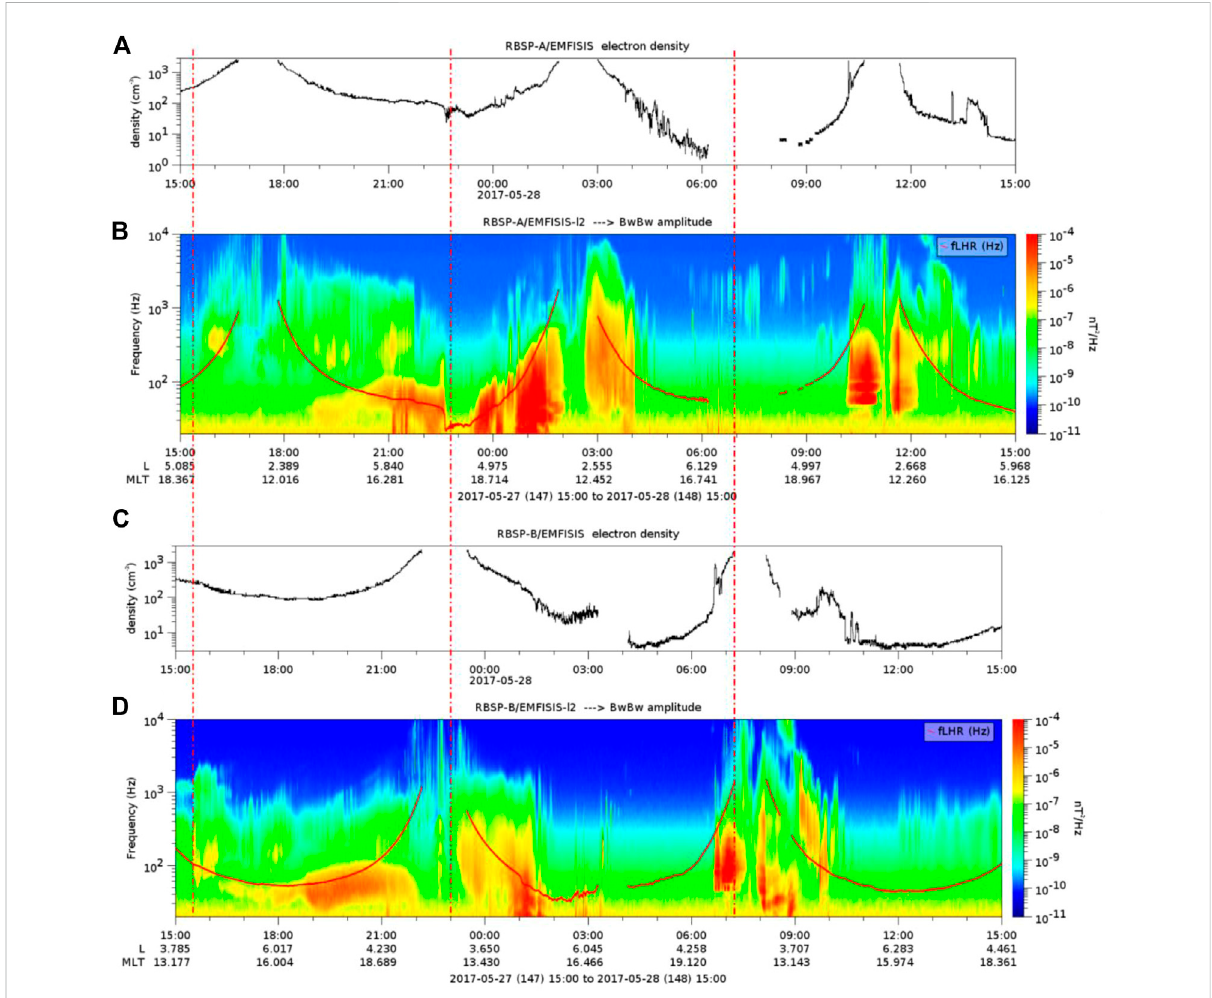
FIGURE 2 ElectrondensityfromVanAllenProbeA (A) andB (C) ,andfrequency-timespectrogramofmagneticspectraldensityfromVanAllenProbeA (B) and B (D) . The red line represents the lower hybrid resonance frequency ( fLHR ). The electron densities and fLHR are obtained from the EMFISIS instrument. The geomagnetic storm period analyzed here is approximately 2 hours before the sudden commencement phase and about 8 hours after the beginning of the recovery phase. The vertical dashed red lines refer to the onset time of the geomagnetic storm ’ s